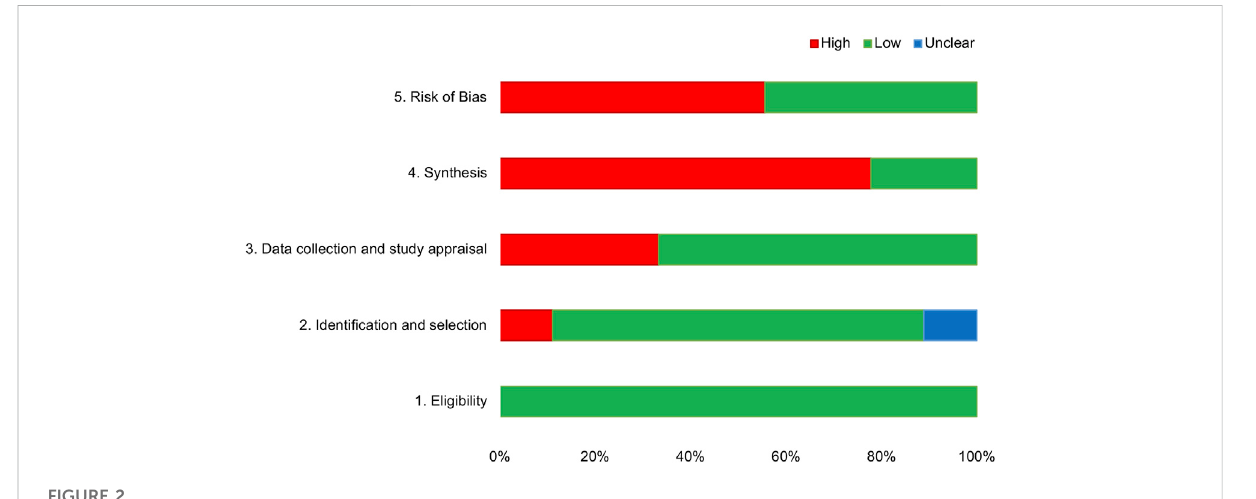
FIGURE 2 Graphical presentation of risk of bias of the included